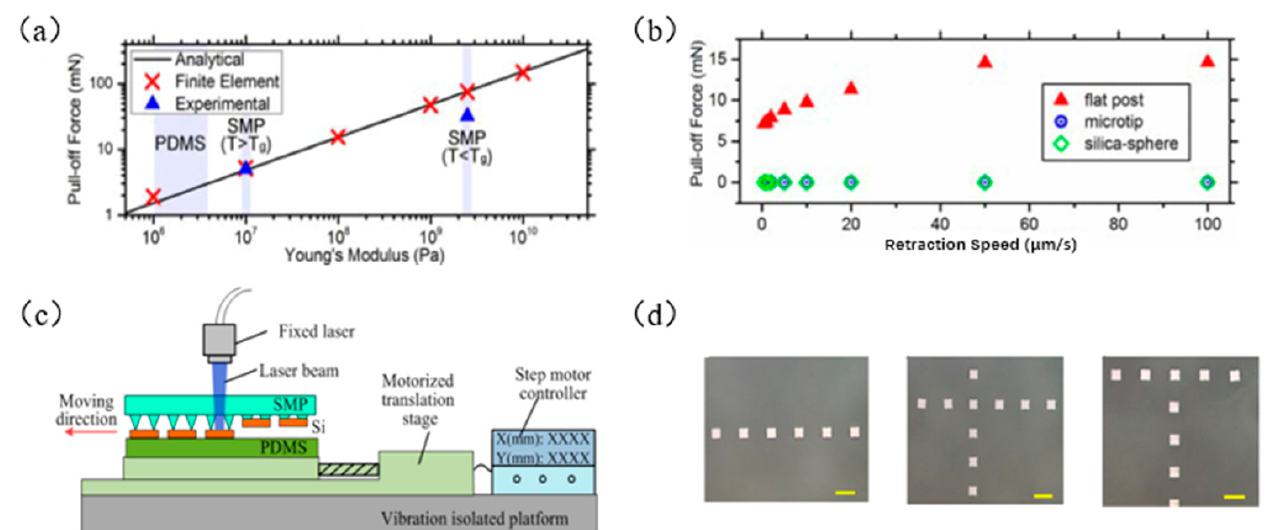
Figure 7. The principle of laser-controlled seal temperature transfer printing technology. ( a ) The relationship between the elastic modulus and the plane stress of the seal (reproduced from [68]), ( b ) the relationship between the two types of seals and the plane stress at different peeling speeds (reproduced from [68]), ( c ) laser programmable selective transfer printing equipment setup diagram (reproduced from [57]), and ( d ) examples of successful transfer printing of straight, cross, and T-shaped patterns (reproduced from [57]).